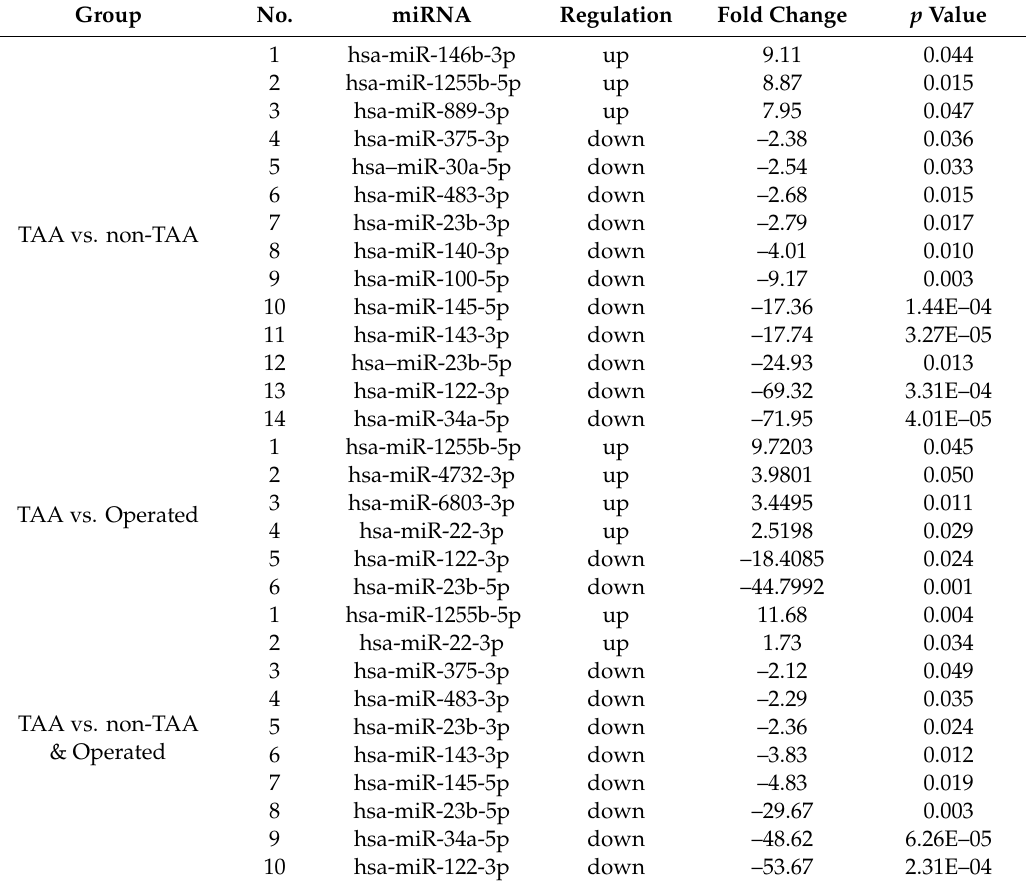
Table 4. List of differentially expressed miRNAs (fold change > 1.5, p value ≤ 0.05-fold and base mean ≥ 20) in TAA patient blood plasma samples compared to miRNA expression levels in non-TAA controls. Group No. miRNA